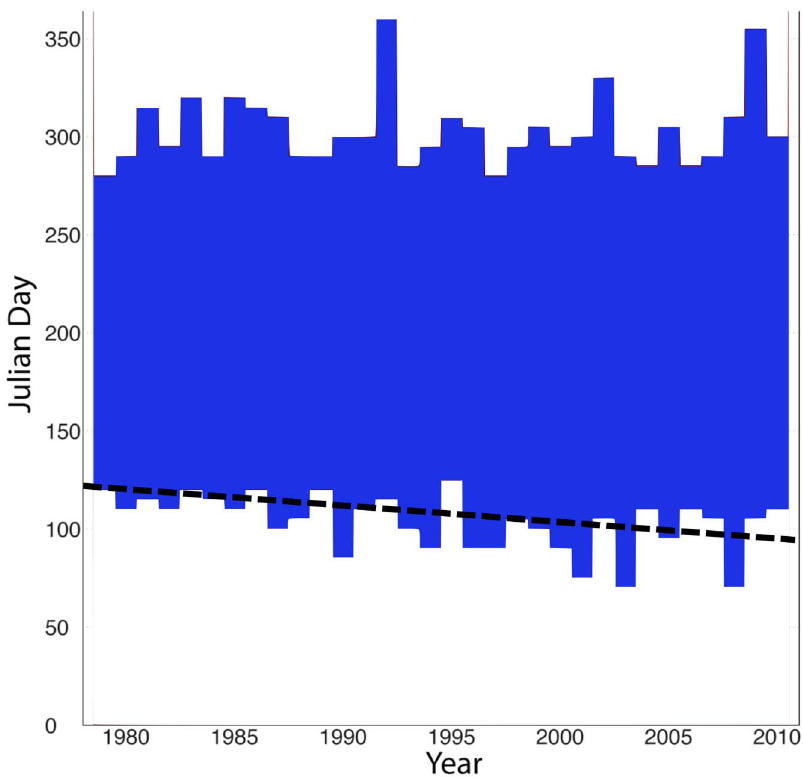
Figure 7. Increased Inter-annual Variability and Total Precipitation. Precipitation data at the study site shows inter-annual variability from 1979 through 2010. The shaded section of the figure represents the period comprising 90% of annual rainfall. In addition to increasing variability since 1990, the monsoon season is arriving earlier as indicated by the downward shift of the trend line.